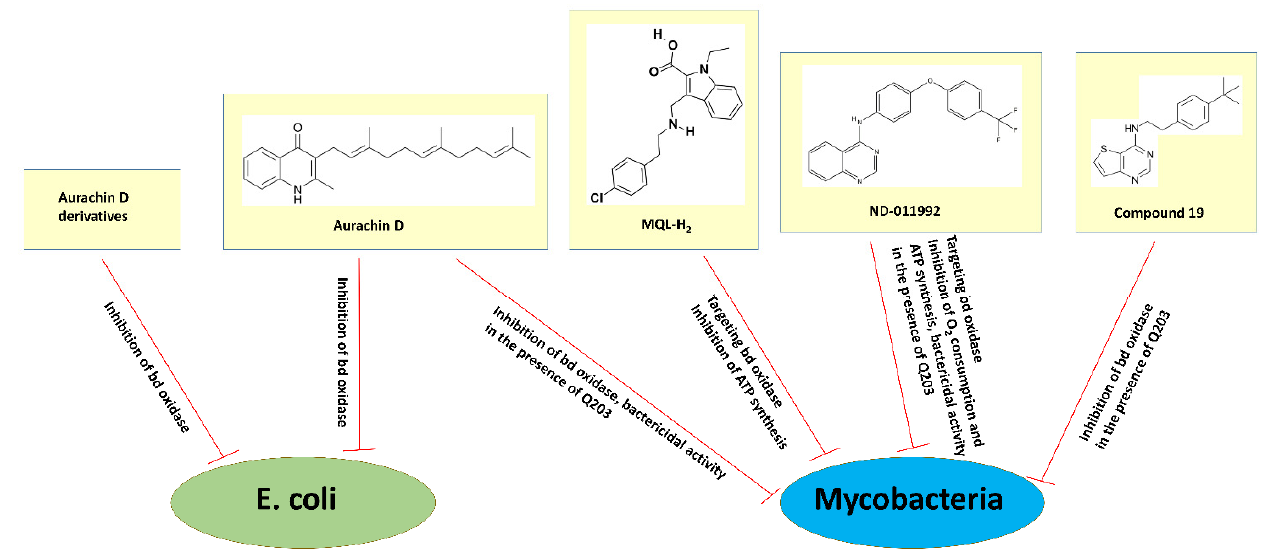
Figure 7. Simplified schematic representation of the effects of compounds targeting the bd ox- idase on the level of the isolated enzyme, membrane vesicles or whole cells. Shown are the structures of aurachin D, 3-[[2-(4-chlorophenyl)ethylamino]methyl]-1-ethyl-indole-2-carboxylic acid (MQL-H 2 ), N -(4-(4-(trifluoromethyl)phenoxy)phenyl)quinazolin-4-amine (ND-011992), and N -(4- ( tert -butyl)phenethyl)thieno [3,2- d ]pyrimidin-4-amine (Compound 19 ). See the main text for details. Data collected from: [10,13,14,116–124].